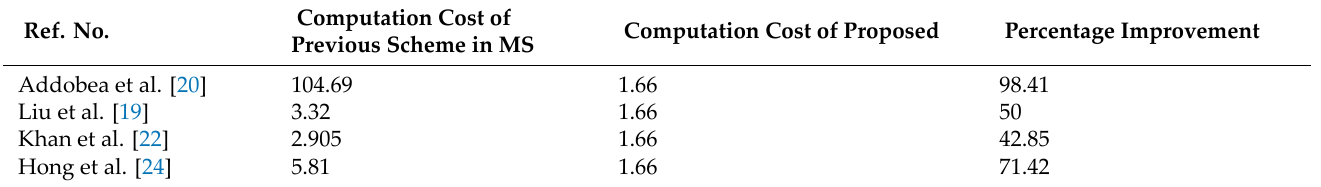
Table 7. Computation overhead improvement.